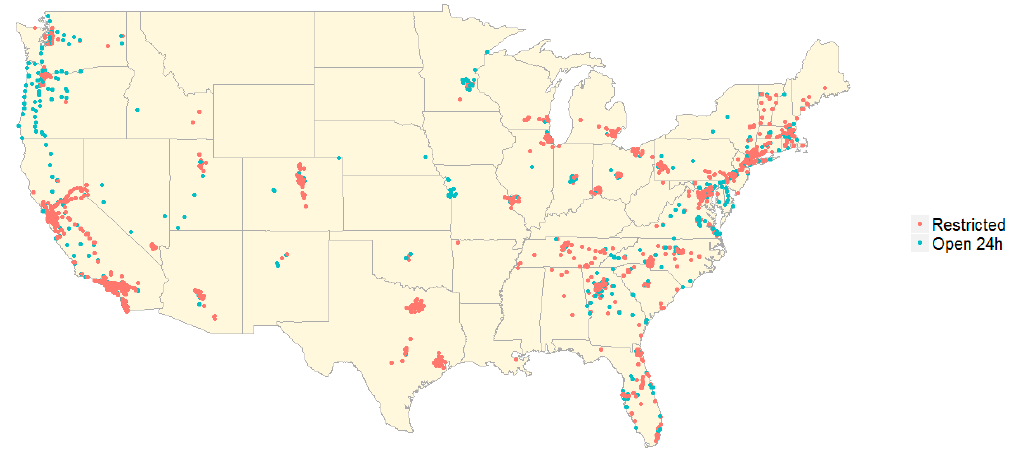
Figure 2. CHAdeMO/Combo in the U.S.